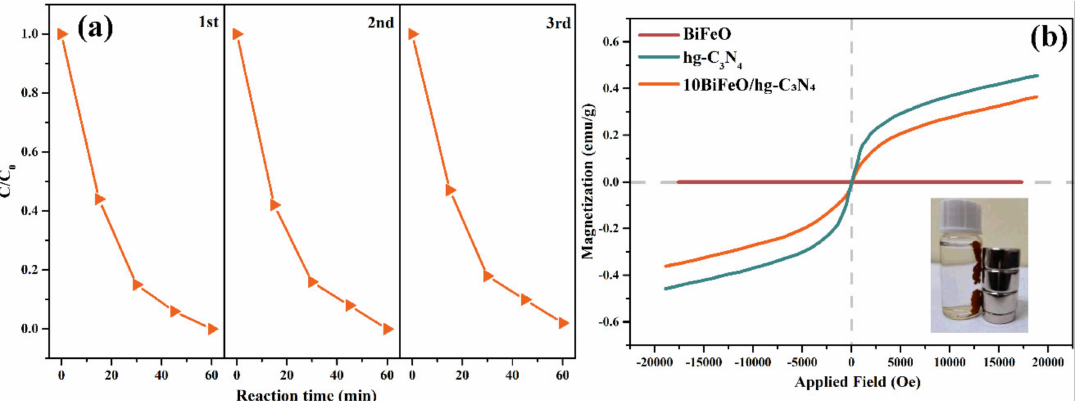
Figure 6. ( a ) Recycling runs for the photocatalytic RhB in the presence of 10BiFeO/hg-C 3 N 4 under visible light irradiation; ( b ) M-H hysteresis loop of 10BiFeO/hg-C 3 N 4 after the photocatalytic